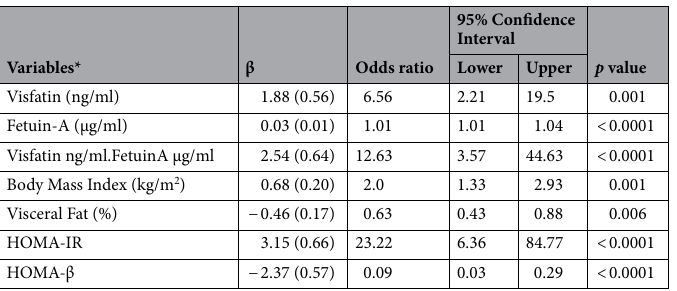
Table 3. The associations of study parameters and other risk factors with incident diabetes—results of multiple logistic regression analyses. Dependent variable: T2DM versus Normal. *Variables that were significantly associated with incident diabetes are shown in the